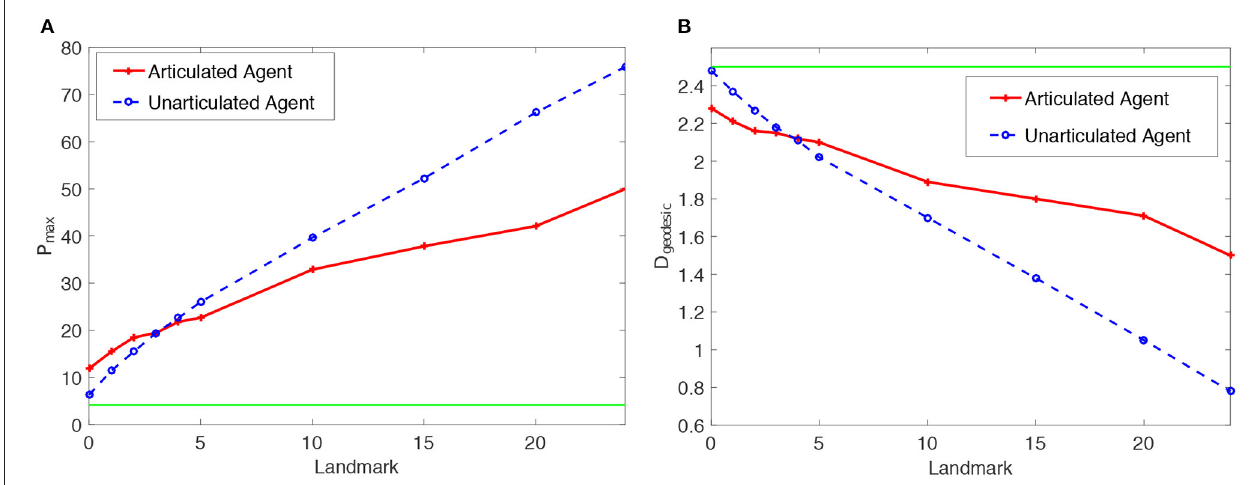
FIGURE 3 | Statistics means of the reconstruction accuracy P max and the geodesic distance D geodesic for the proposed articulated tactile learning model and the unarticulated model when representing a 2 2 2 cube. (A) P max for the models, where the green line stands for the theoretical value of P max by random guess. (B) × × D geodesic for the models, where the green line stands for the theoretical value of D geodesic by random guess.